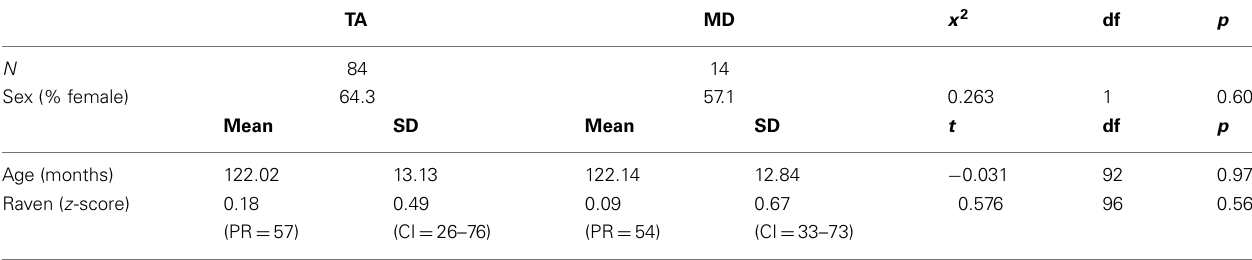
Table 1 | Descriptive data of the individual assessment